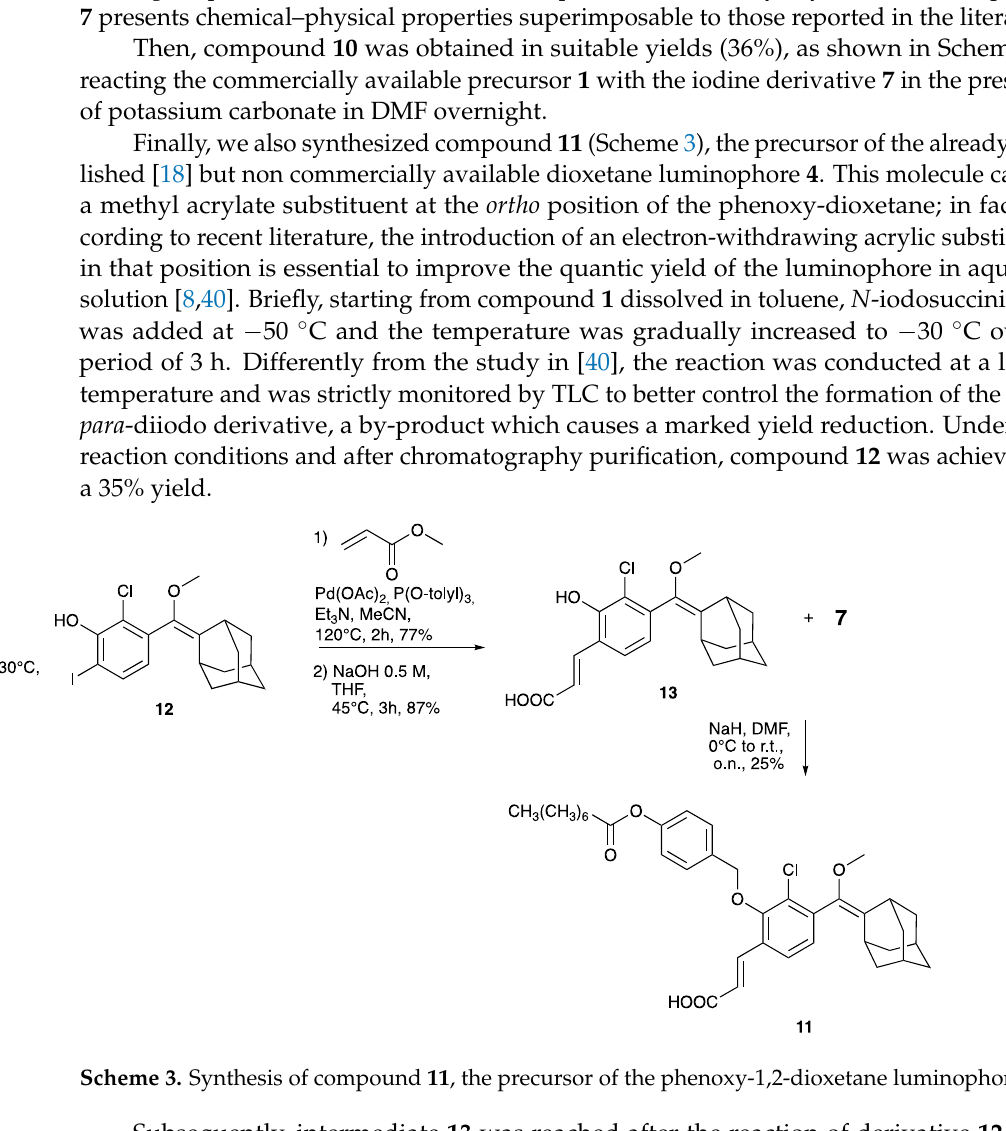
Scheme 2. Synthesis of compound 10 , the precursor of the phenoxy ‐ 1,2 ‐ dioxetane luminophore 3 : ( A ) synthesis of the spacer ‐ trigger molecule 7 ; ( B ) synthesis of compound 10 starting from the com ‐ mercially available precursor 1